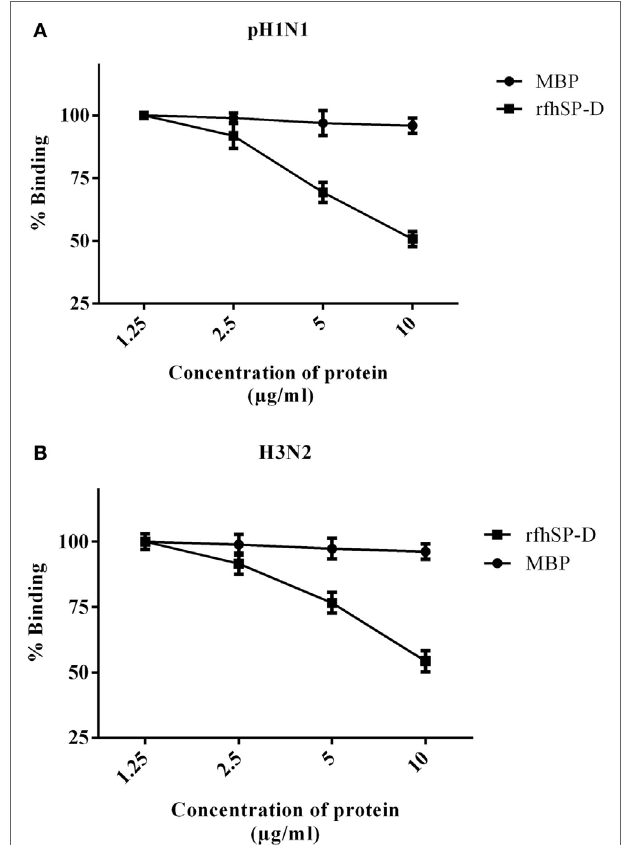
FigUre 3 | Cell-binding assay to show binding of (a) pH1N1 and (B) H3N2 pre-incubated with rfhSP-D to A549 cells. Microtiter wells were coated with A549 cells (1 × 10 5 cells/ml) and incubated overnight at 37°C. Varied concentrations of pre-incubated rfhSP-D (10, 5, 2.5, and 1.25 µg/ml) with pH1N1 and H3N2 virus were added to the corresponding wells, followed by incubation at room temperature for 1–2 h. After fixing the cells with 4% paraformaldehyde solution, monoclonal anti-influenza virus H1, or polyclonal anti-influenza virus H3 were added to corresponding well. Maltose-binding protein (MBP) was used as a negative control protein. The data were expressed as mean of three independent experiments done in triplicates ± SEM.